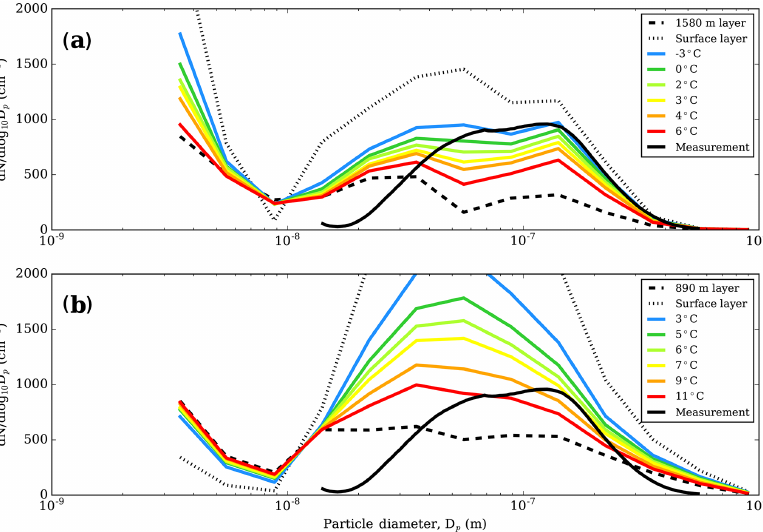
Figure 5. Observed and temperature-dependent simulated mean particle number size distributions for the measurement period for the (a) coarse simulations (4 ◦ × 5 ◦ ) and (b) nested resolution (0.5 ◦ × 0.667 ◦ ). The solid black line indicates the measured data, the black dashed line indicates the 890m simulated layer, the black dotted line indicates the simulated surface layer, and the colored lines indicate various temperature thresholds, where cool colors indicate colder threshold values and warmer colors indicate warmer threshold